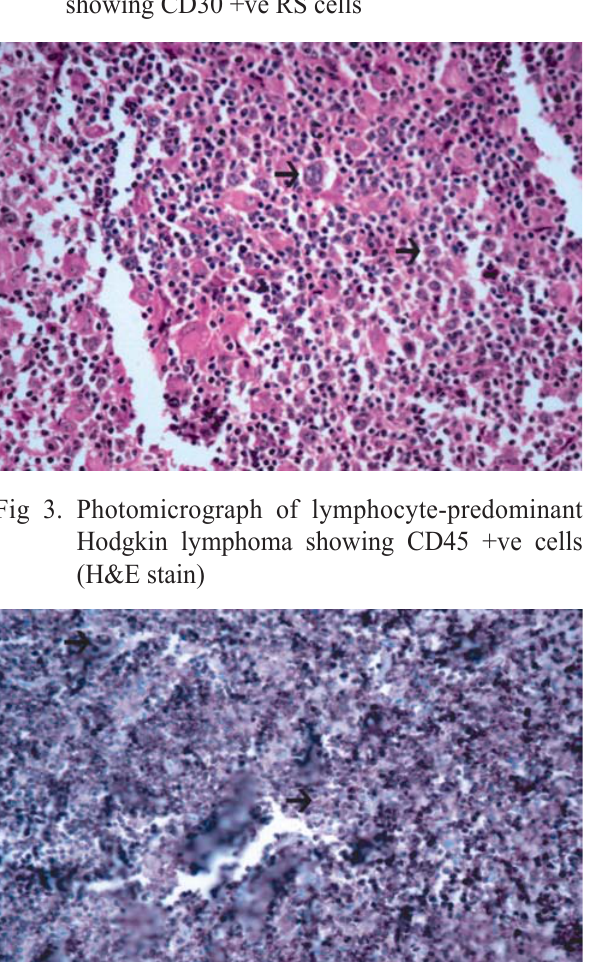
Fig 2. Photomicrograph of classical Hodgkin lymphoma